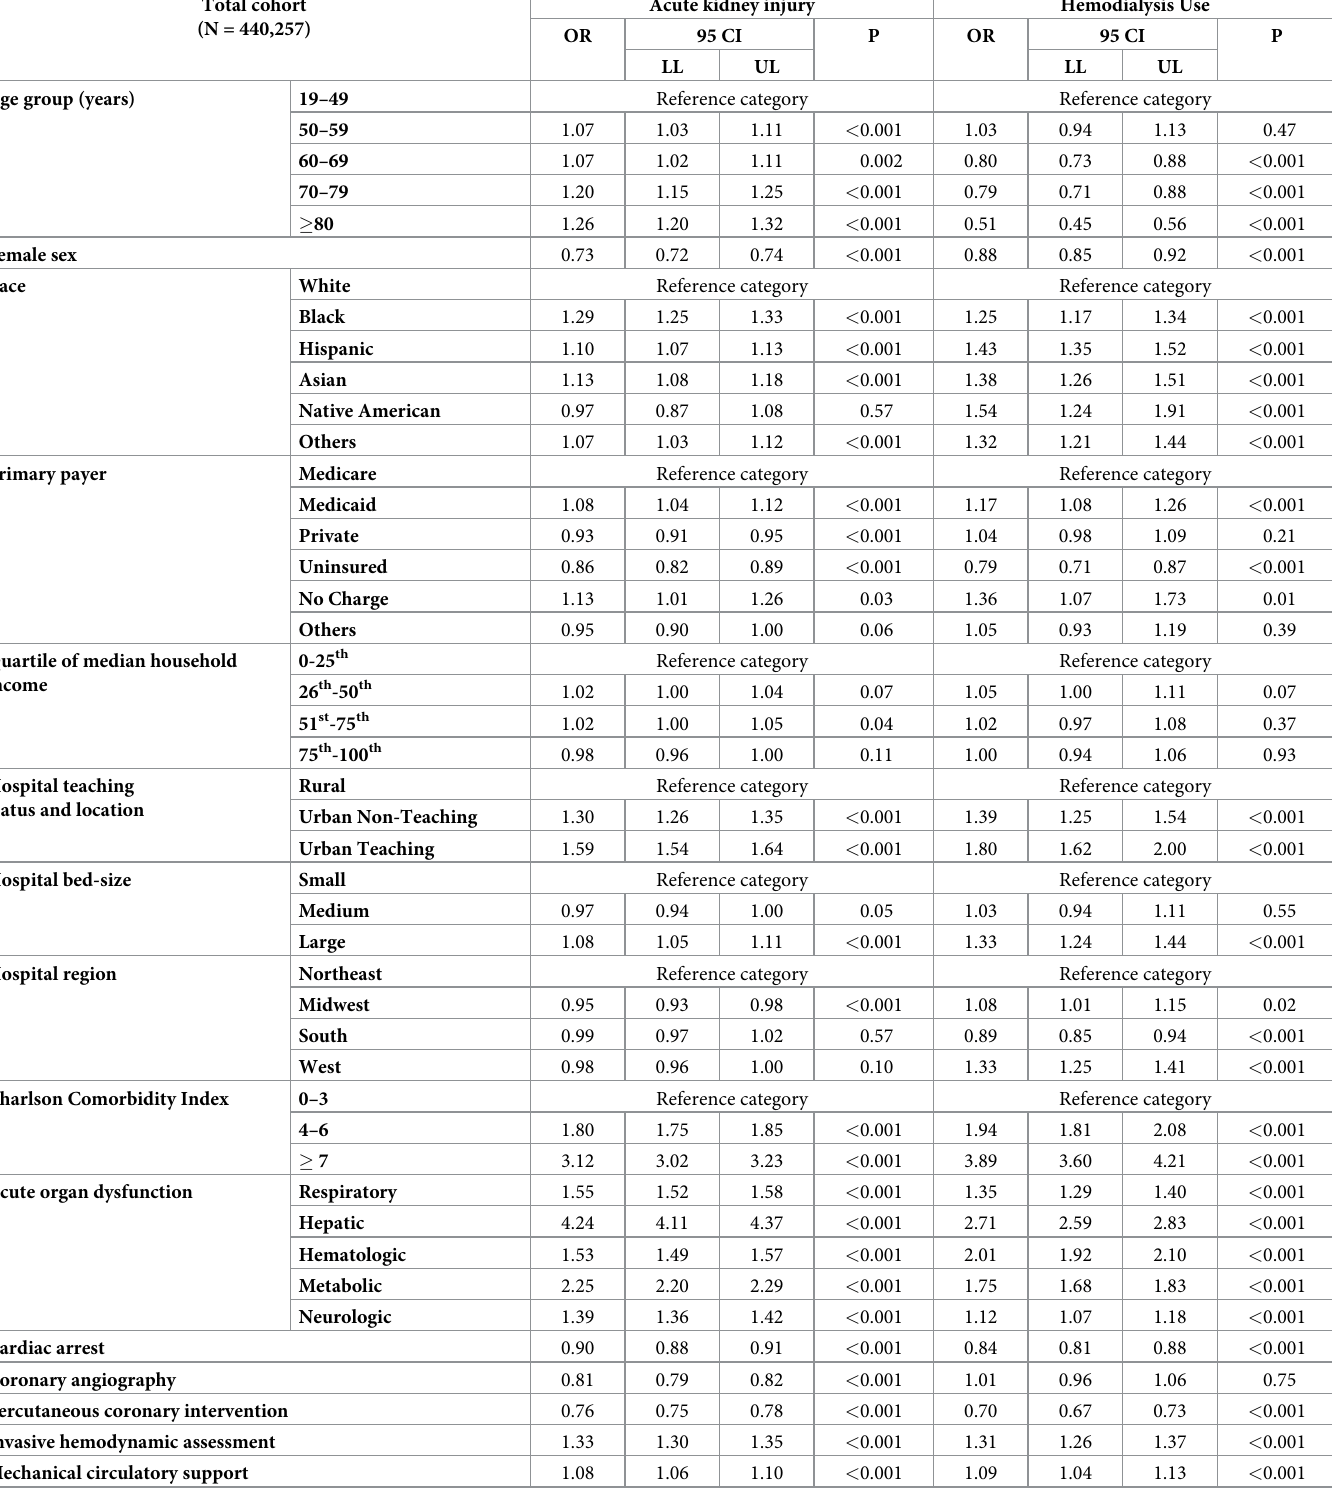
Table 2. Multivariable regression for predictors of AKI and hemodialysis use in AMI-CS. Total cohort (N =